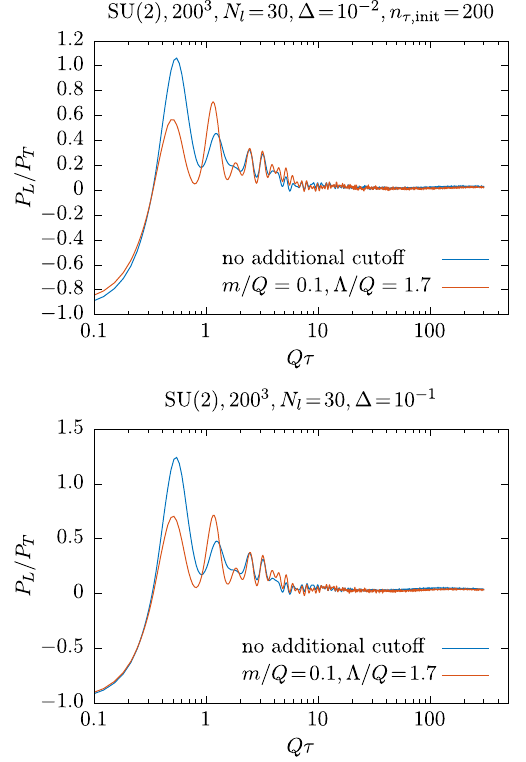
Fig. 11 Pressure ratio in the expanding system with different cutoffs and fluctuation seeds. No isotropisation is observed for any choice of parameters